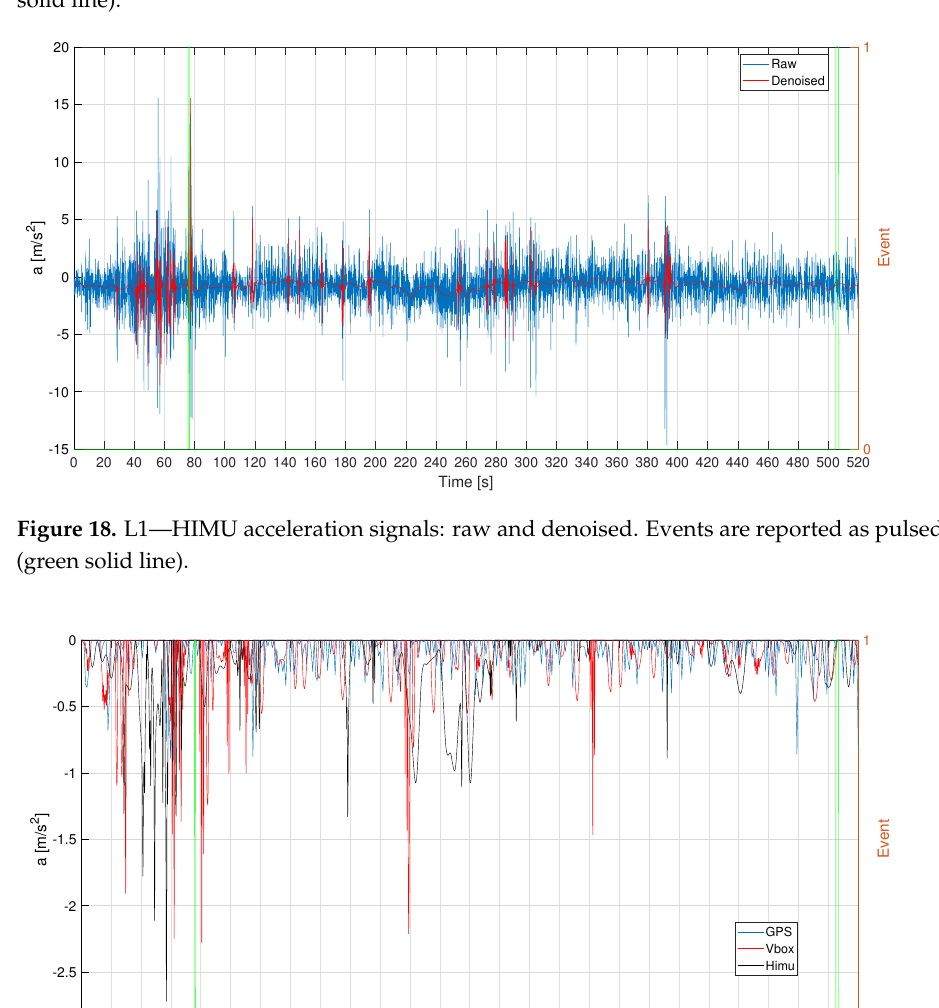
Figure 17. L1—VBOX and GPS acceleration raw signals. Events are reported as pulsed train (green solid line).